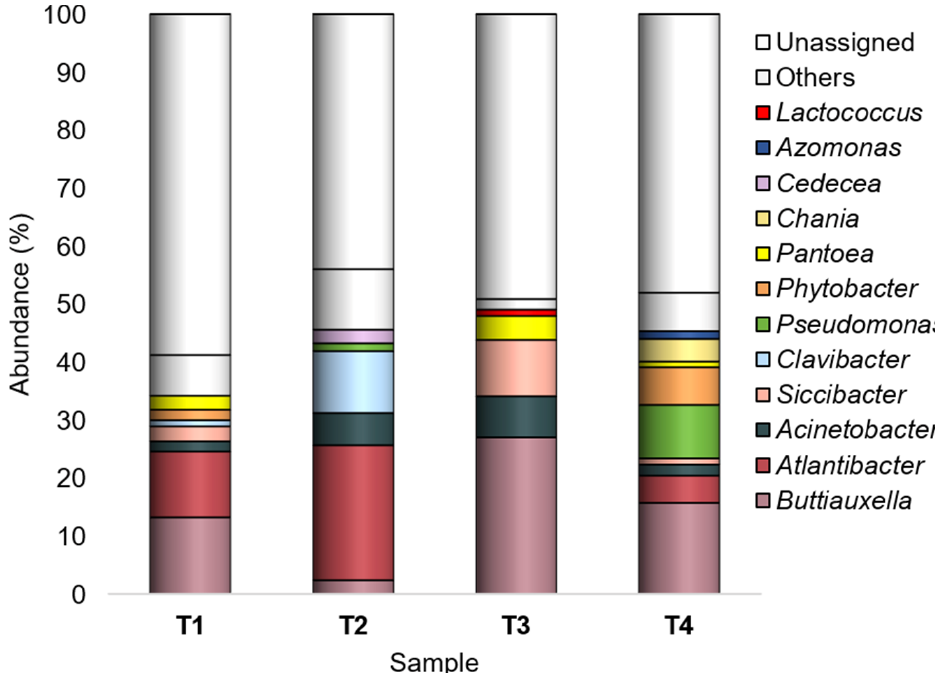
Figure 3. Bacterial composition at the genus level. Distribution of the major genera (Ra ≥ 1% in at least one sample); genera with Ra < 1% were gathered in “Others”. T1: WT/OF, T2: WT/CF, T3: SB/OF, T4: SB/CF.